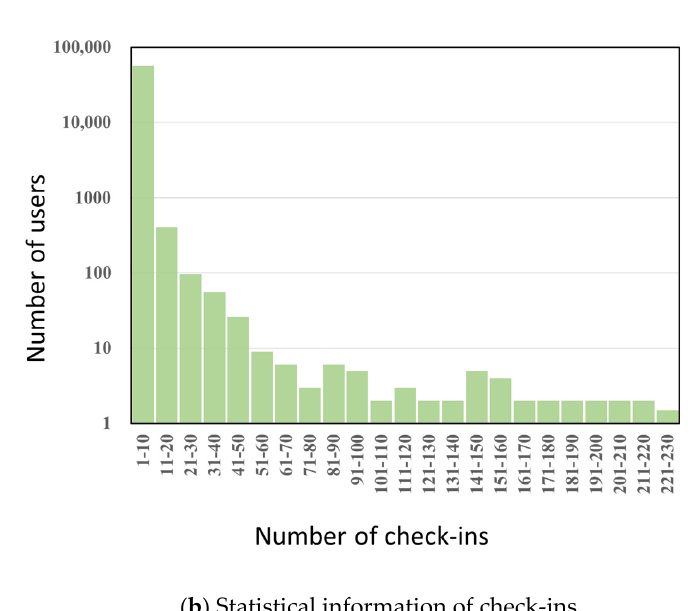
Figure 8. Overview of the social media check-ins for New York City: ( a ) Geographical distribution of check-ins. Most of the check-ins are concentrated in the middle and south, while there are few in the north; ( b ) Statistical information of check-ins. The statistical information of different users demonstrates a long tail effect, with the number of check-ins per user ranging from 1 to